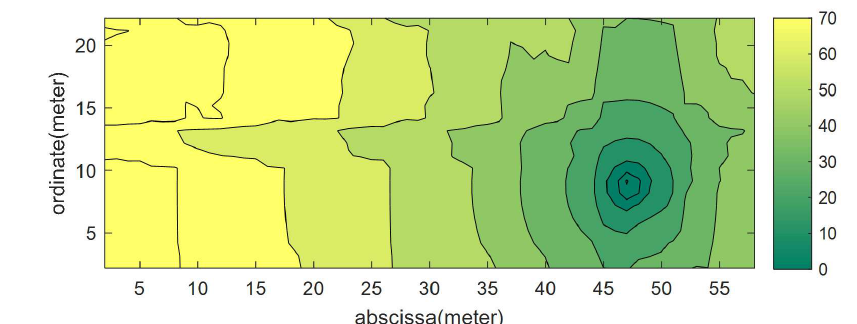
Figure 9. An estimated path loss map of a sensor.